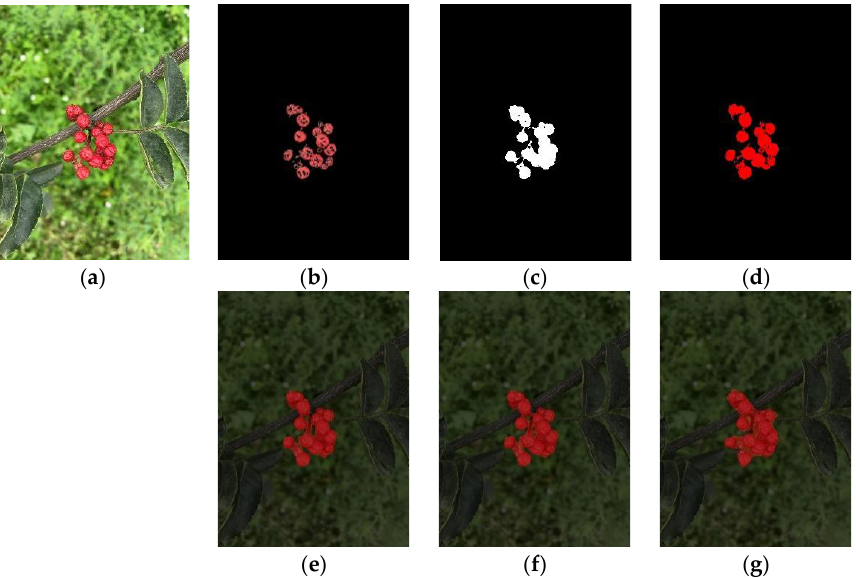
Figure 10. ( a ) Single front-lit cluster without occlusion; ( b ) results from RGB algorithm for segmentation; ( c ) results from HSV algorithm for segmentation; ( d ) results from k-means algorithm for segmentation; ( e ) results from U-Net algorithm for segmentation; ( f ) results from DeepLabV3+ algorithm for segmentation; ( g ) results from PSPnet algorithm for segmentation.